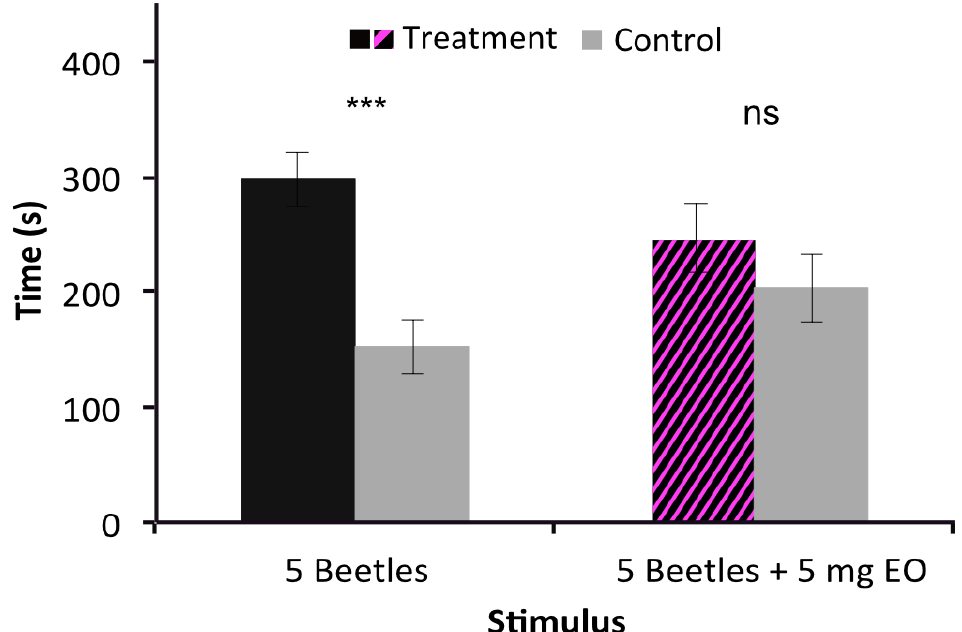
Figure 3. Behavioral responses to the aggregation pheromone alone (5 beetles) and in combination with a repulsive dose of the essential oil (EO). ns, not significant, *** p < 0.001.